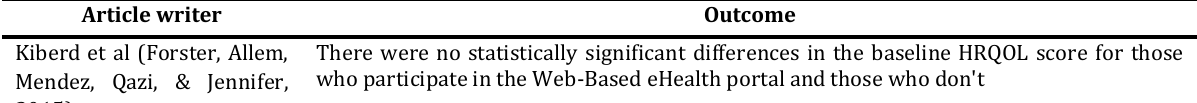
Table 1. List of outcome health education based on the information